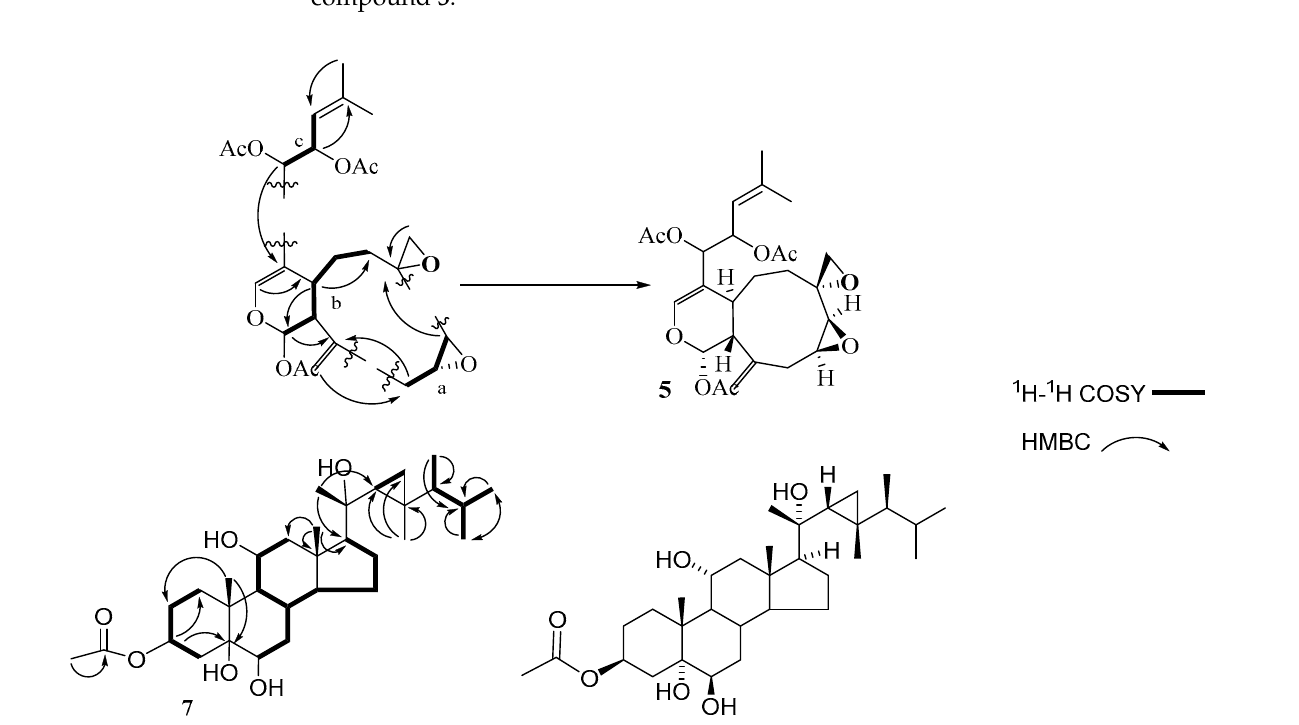
Figure 3. Selected COSY and HMBC correlations of 5 and 7 .